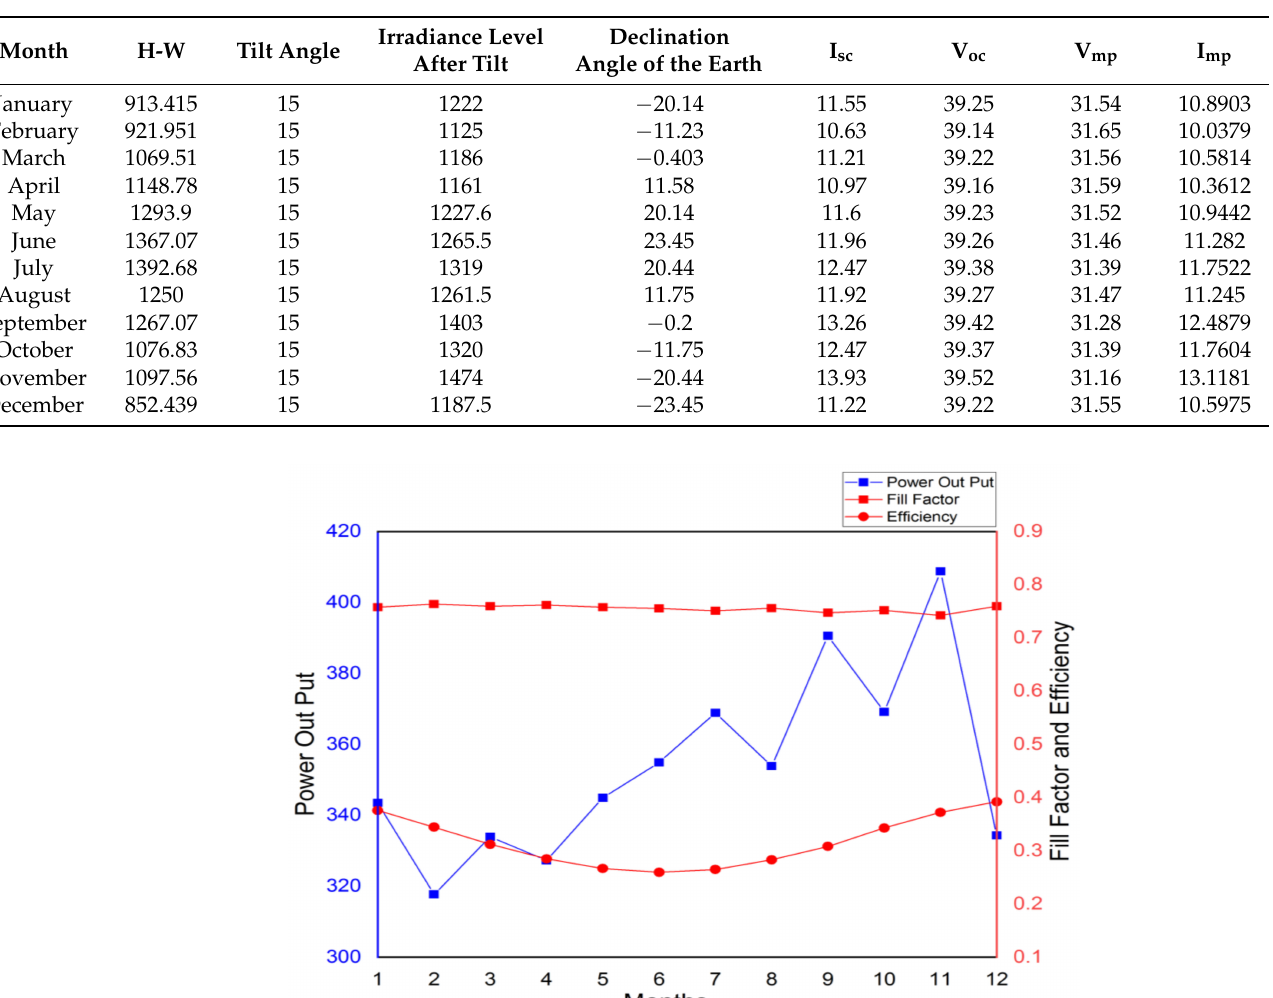
Table 5. Monthly specific daily global irradiance (H), optimal tilt angle (deg), declination angle of the